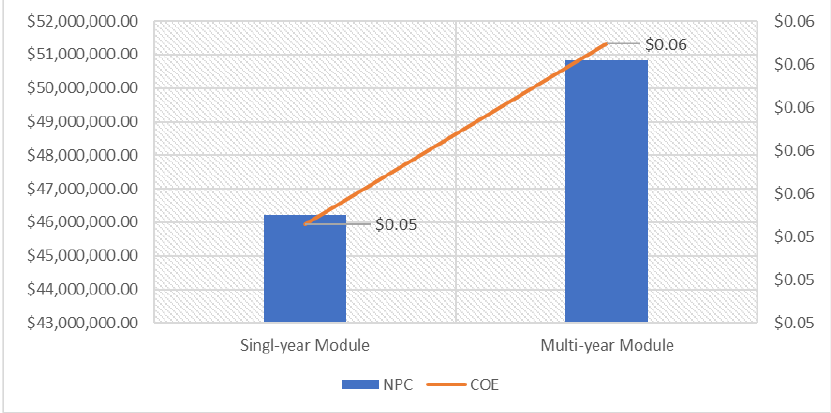
Figure 14. NPC and COE for multi-year and single-year modules .